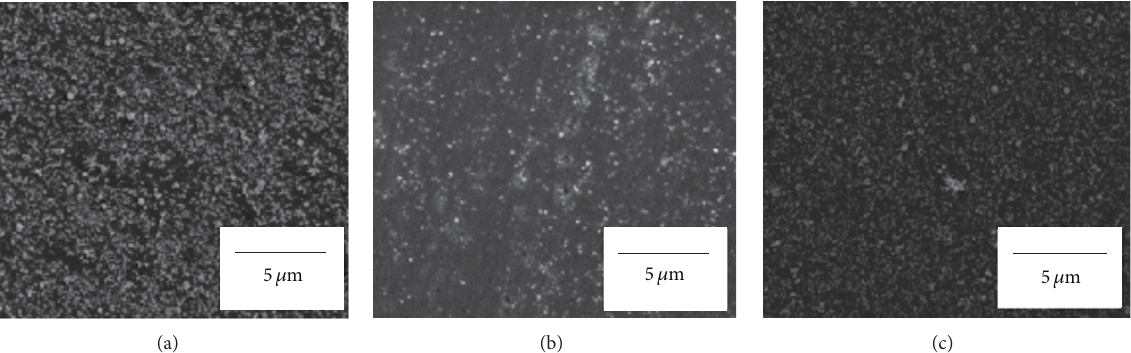
Figure 4: Surface SEM images of films deposited at various bias frequencies (10Hz, 1 kHz, and 100kHz), with bias voltage of 0.5 V and Y 2 O 3 concentration of 0.5 wt% in a suspension